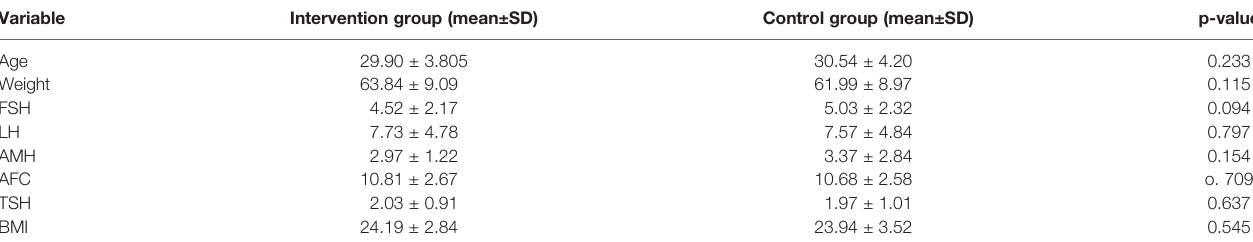
TABLE 1 | Patients ’